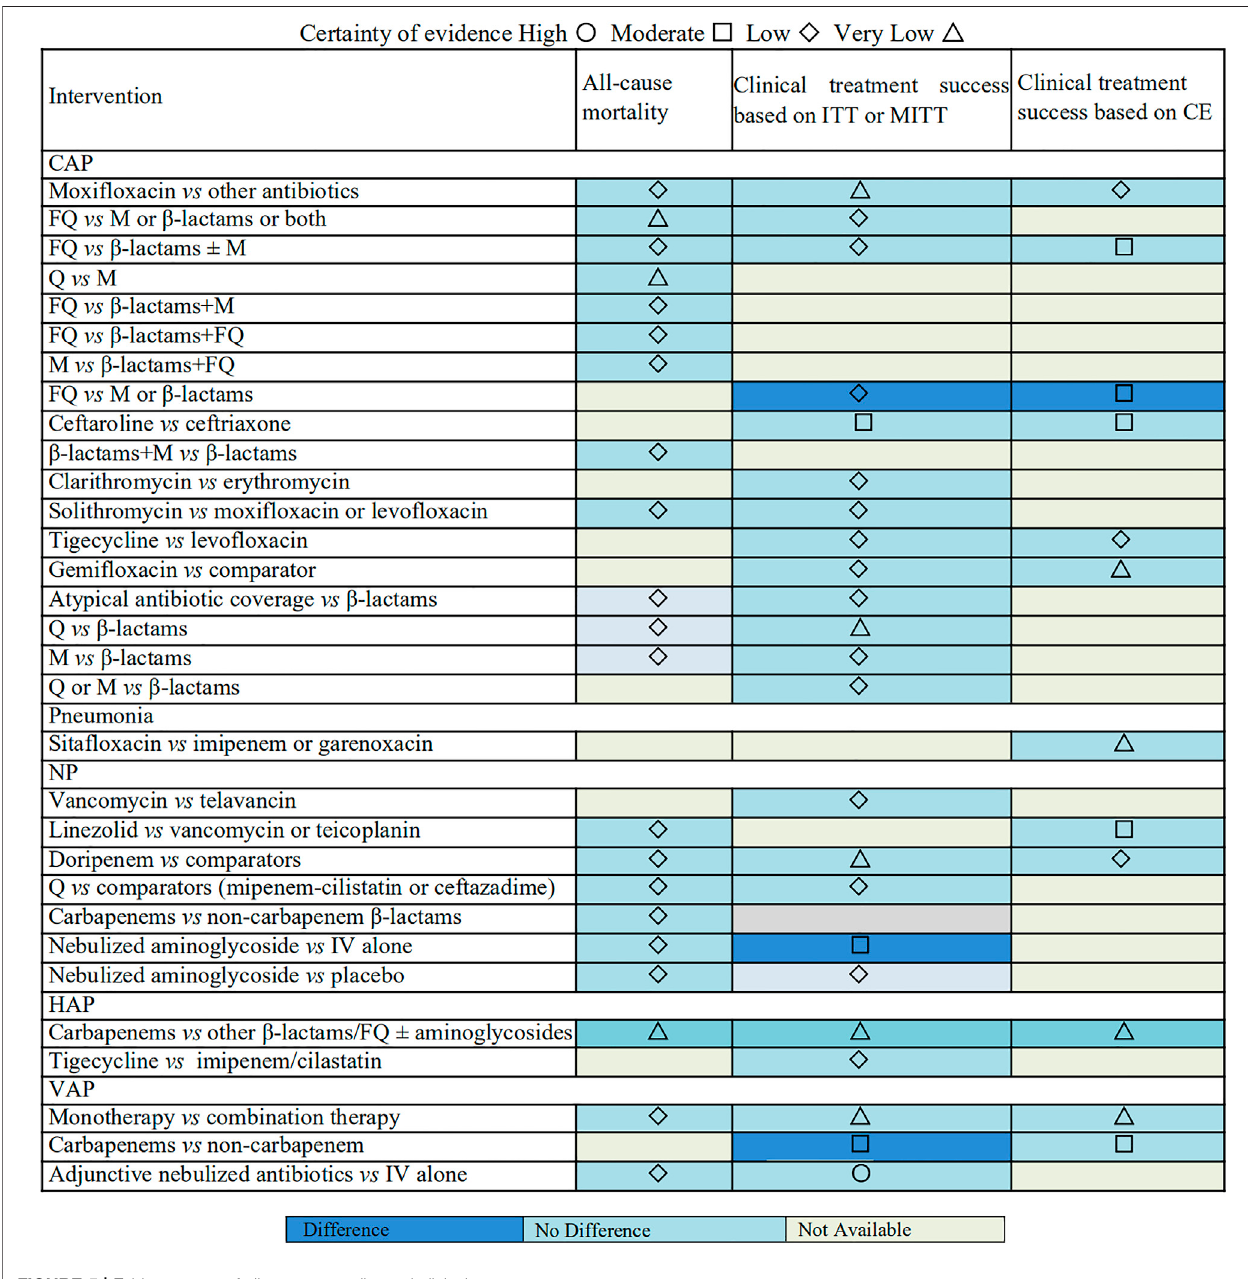
FIGURE 5 | Evidence map of all-cause mortality and clinical treatment